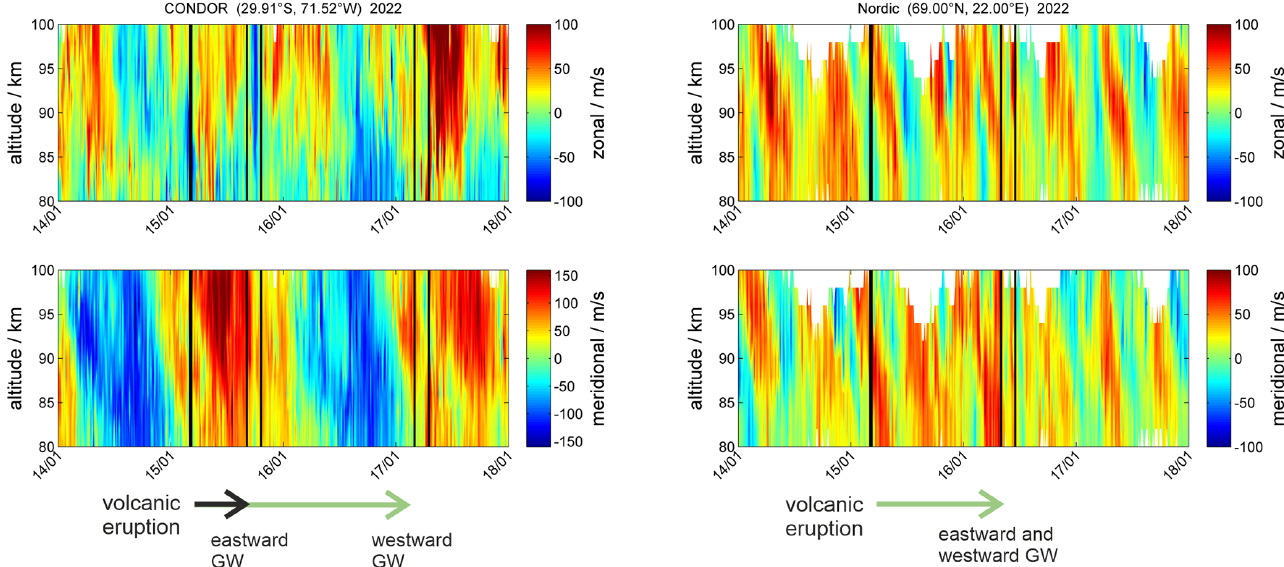
Figure 2. Zonal and meridional winds obtained by the 3DVAR+DIV algorithm above CONDOR and the Nordic Meteor Radar Cluster with a temporal resolution of 10min. The first solid vertical black line indicates the time of the main eruption on 15 January 2022 at 04:15UTC. The dark grey lines embrace the signature of the volcanic gravity wave (GW) signature in each domain. Horizontal arrows emphasize the time of the volcanic eruption and the arrival times of the eastward- and westward-propagating gravity waves for both meteor radar